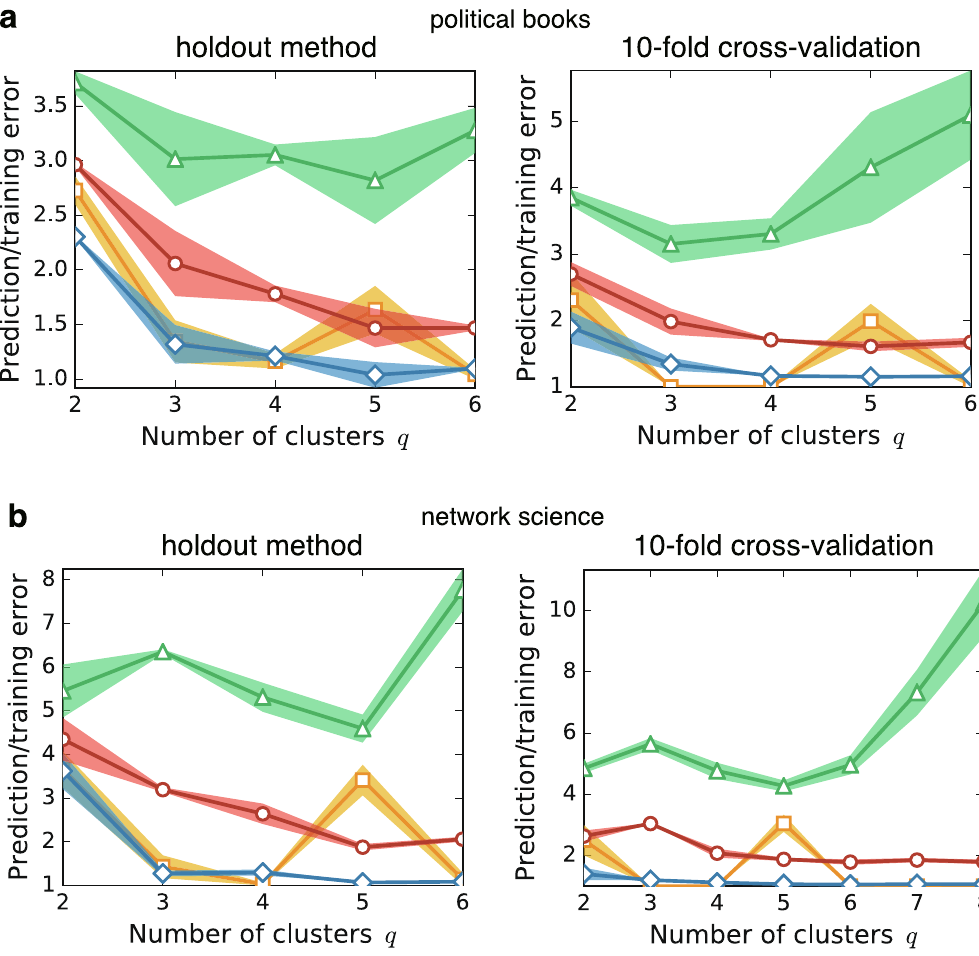
Figure 9. Cross-validation errors using the holdout method and the 10-fold cross-validation. As in Fig. 3, the four data in each plot indicate the Gibbs prediction errors E Gibbs (green triangles), MAP estimates E MAP of E Gibbs (yellow squares), Bayes prediction errors E Bayes (red circles), and Gibbs training errors E training (blue diamonds). In the holdout method, we randomly selected 1% of the edges (5 edges in ( a ) political books and 10 edges in ( b ) network science ) as the holdout set. The solid lines represent the average values obtained by repeating the prediction process 10 times and the shadows represent their standard errors. For the K -fold cross-validation, we set K = 10. Although it is common to take average over different choices of K partition, we omitted this averaging